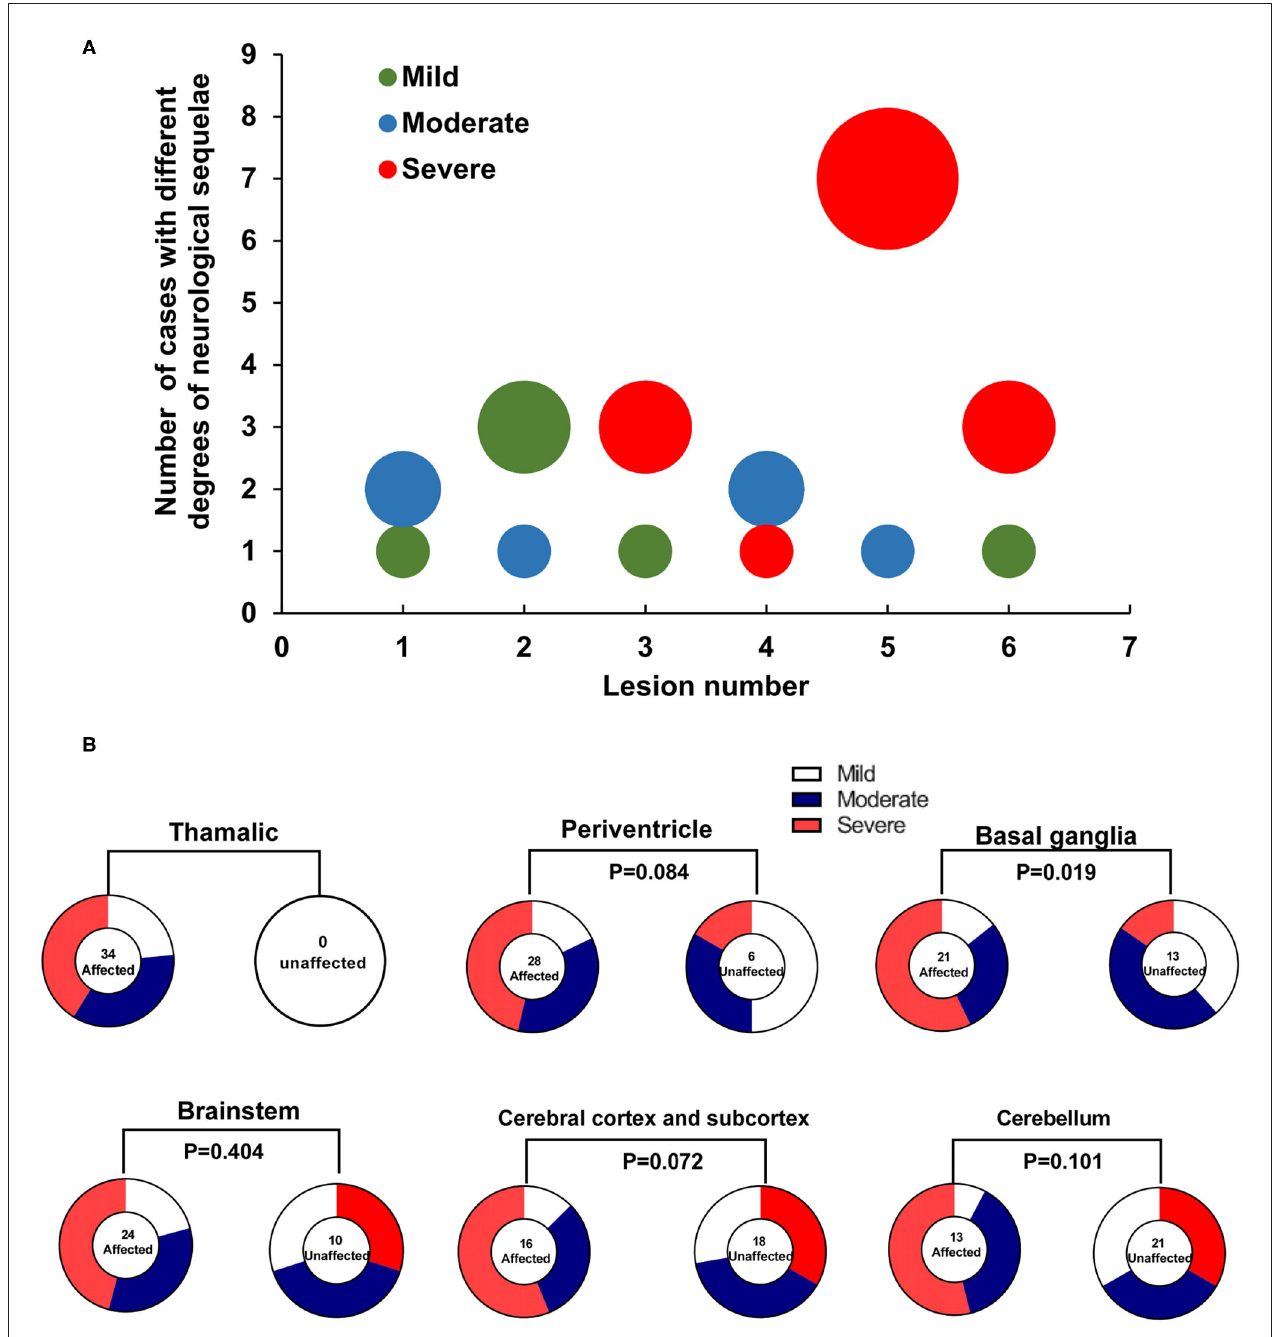
FIGURE 2 | The association of lesions in brain to the severity of neurological sequelae in ANE patients. (A) Distribution difference in the number of brain lesion locations in 34 survival ANE patients with varying degrees of neurological sequelae. (B) The association of brain lesion locations to the severity of neurological sequelae in 34 survival ANE